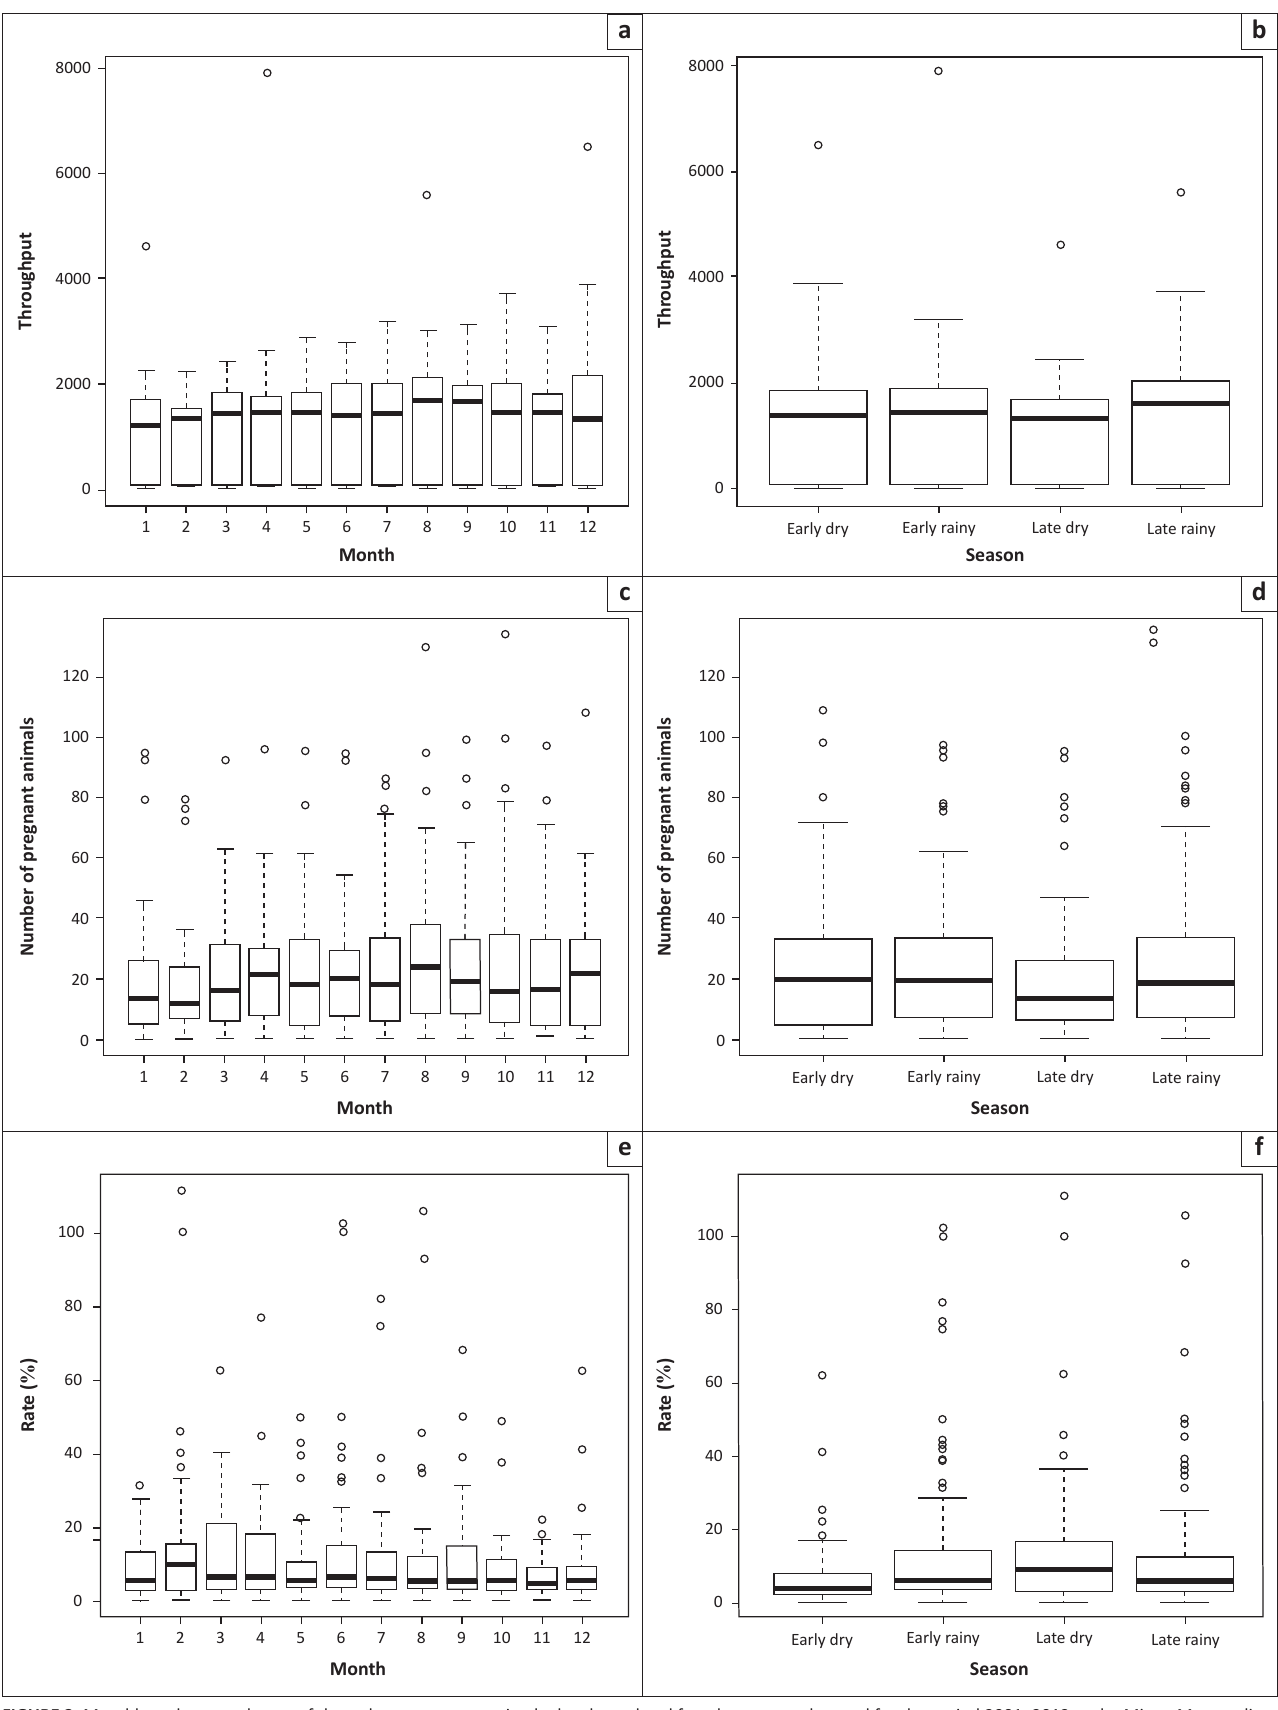
FIGURE 2: Monthly and seasonal rates of throughput, pregnant animals slaughtered and foetal wastages observed for the period 2001–2012 at the Minna Metropolitan Abattoir, Nigeria. (a) Monthly throughput (all species), (b) seasonal throughput (all species), (c) monthly slaughter (all pregnant animals), (d) seasonal slaughter (all pregnant animals), (e) monthly rate of foetal wastages (all species) and (f) seasonal rate of foetal wastages (all